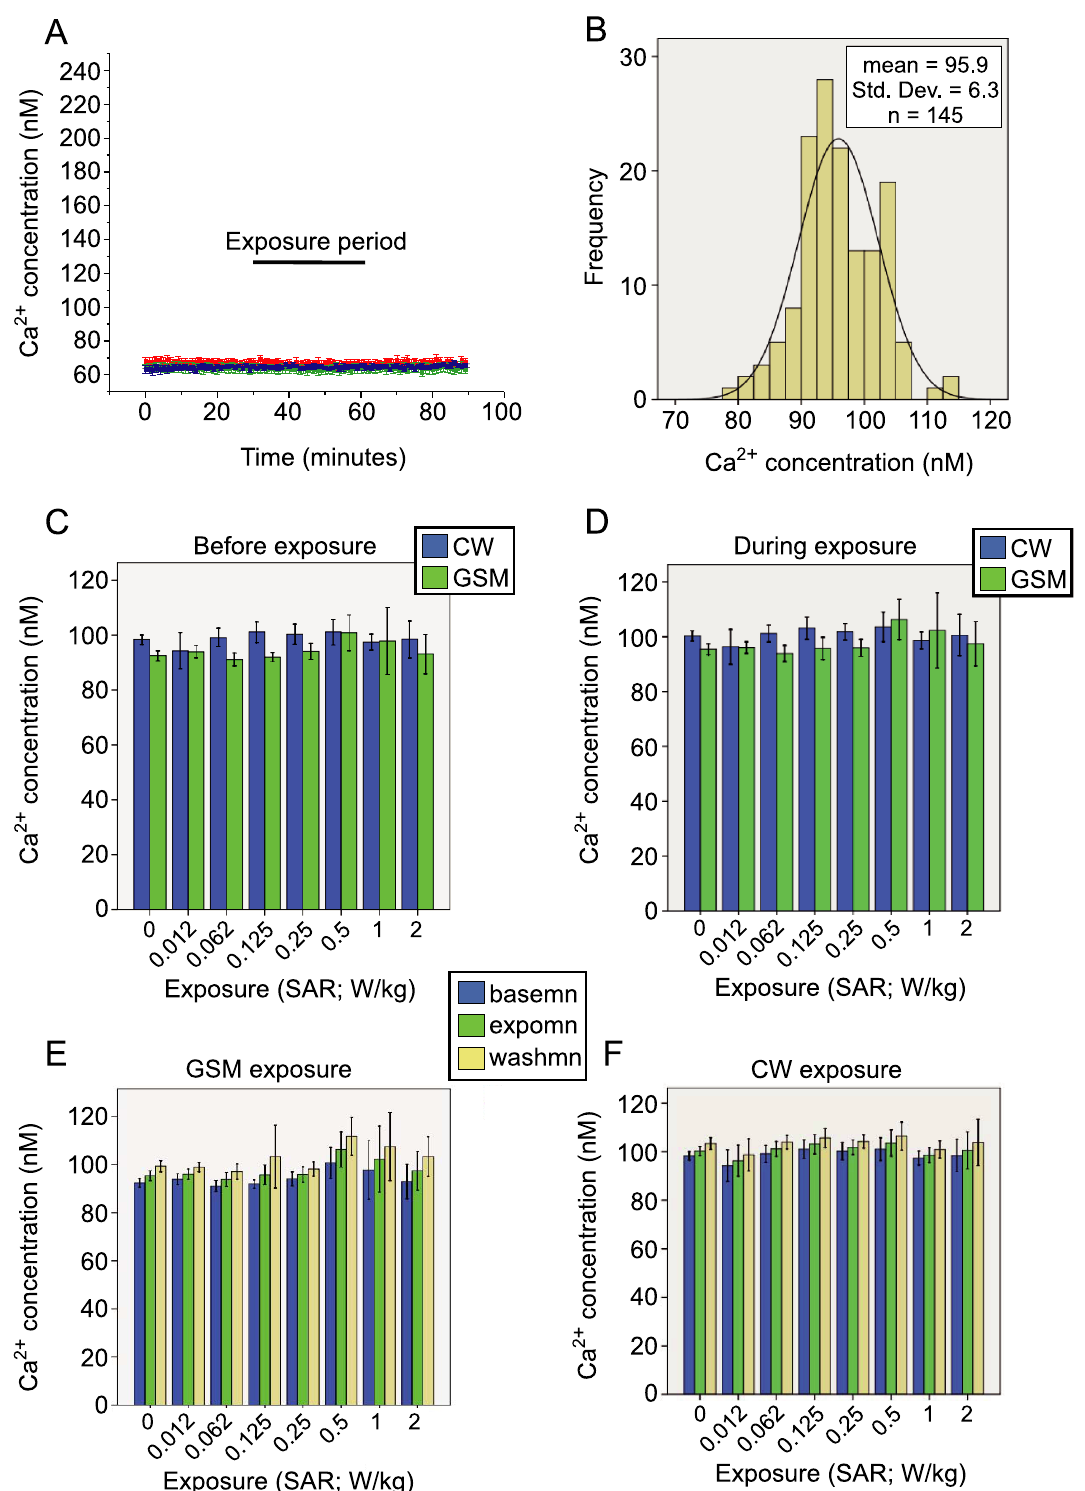
Figure 4. Resting Ca 2 + Concentration in Human Endothelial Cells Exposed to RF Fields. A ; Sample traces showing the experimental protocol. Cytosolic Ca 2 + was measured in EA.hy926 cells exposed to 900 MHz RF at 7 levels of SAR using either GSM-modulated or continuous wave (CW) power. B ; Cytosolic Ca 2 + was normally distributed, permitting the use of parametric statistical tools (Kolmogorov-Smirnov Z=0.739, p=.65, tested against a normal distribution). C ; No significant differences were noted in the baseline concentration of Ca 2 + across groups before the exposure period (F(7,145)=1.15, p=0.34). D ; During the exposure period, no significant differences were observed in the mean Ca 2 + concentration of cells exposed to any of the 7 levels of SAR for a 30-minute exposure period, when compared to unexposed cells (F(7,75)=2.19, p=.05) (an unexposed sample (SAR of 0 W/kg) was run simultaneously with each exposed coverslide). No interaction effect for modulation was observed, as there was no